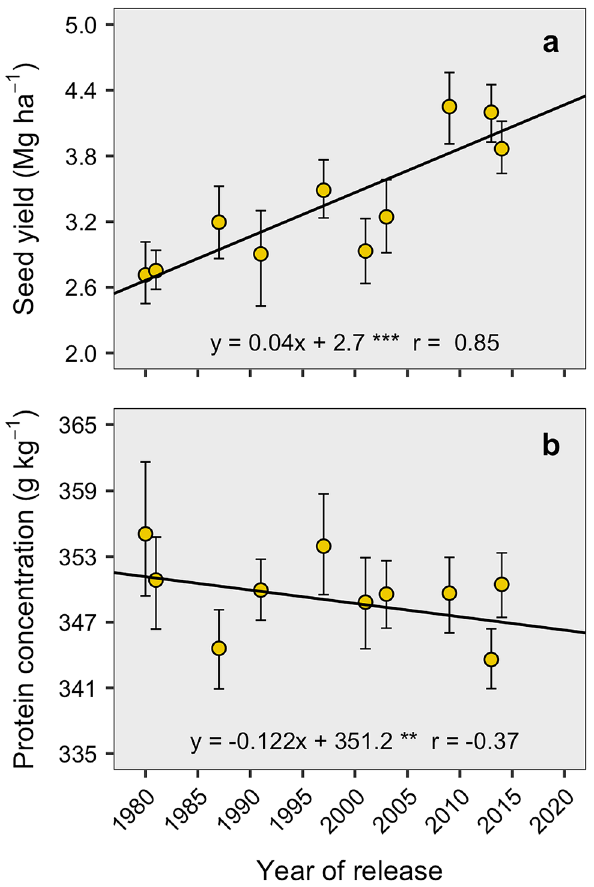
Figure 1. Relationship between seed yield (13 g kg − 1 of moisture content) ( a ), protein concentration ( b ), and year of release of 13 genotypes released from 1980 to 2014 period. Each point represents the mean of both N treatments and genotypes (if more than one per year). Solid black lines denote the best fitted linear model. Asterisks indicate significance of the coefficient: *** P < 0.001; ** P < 0.01. The r value represents the Pearson